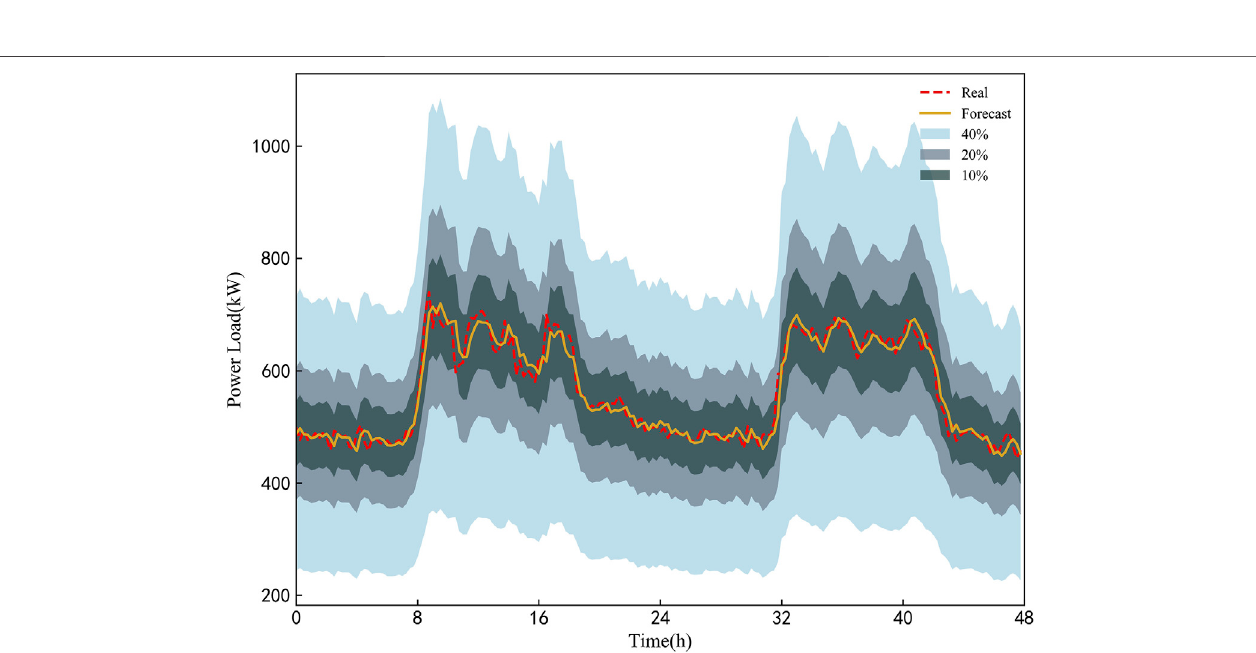
FIGURE 10 | PIs under different con fi dence levels obtained by the proposed ConvLSTM-MDN model in experiment 2.